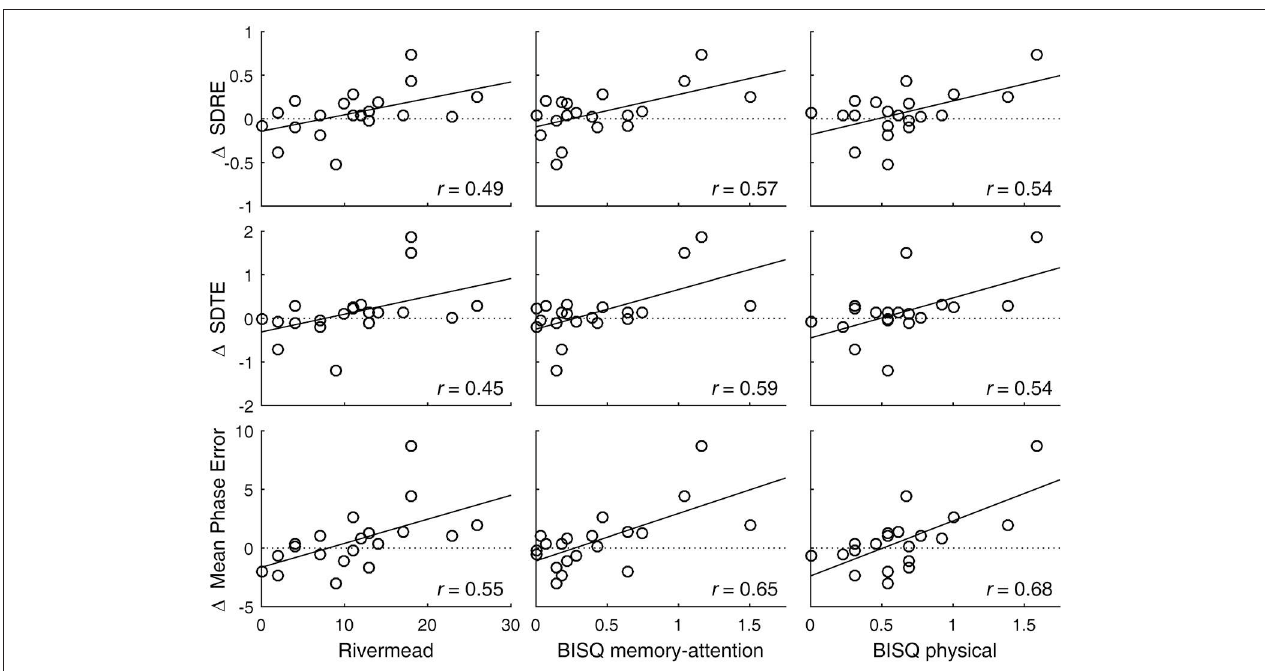
FIGURE 2 | Visual tracking performance changes are associated with post-concussion symptomatology. Circle markers in each panel indicate individual subjects. A regression line is drawn to indicate a trend. A positive change in SDRE and SDTE indicates an increased gaze position variability during tracking of a moving target. A positive change in mean phase error indicates a phase advancement. Also see Table 2